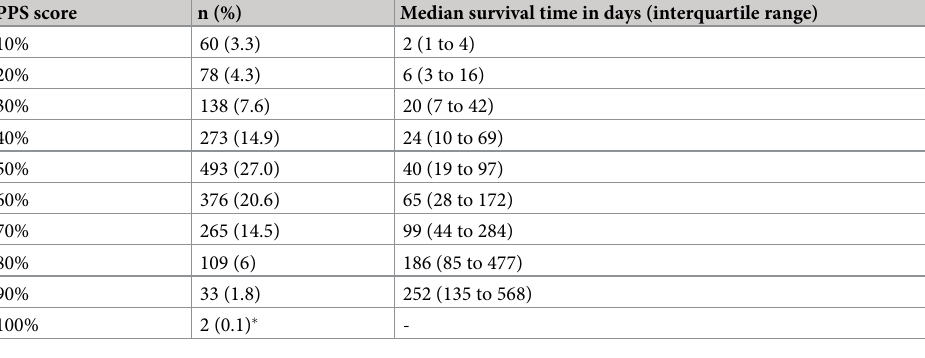
Table 3. Number of participants and median survival time in each of the PPS